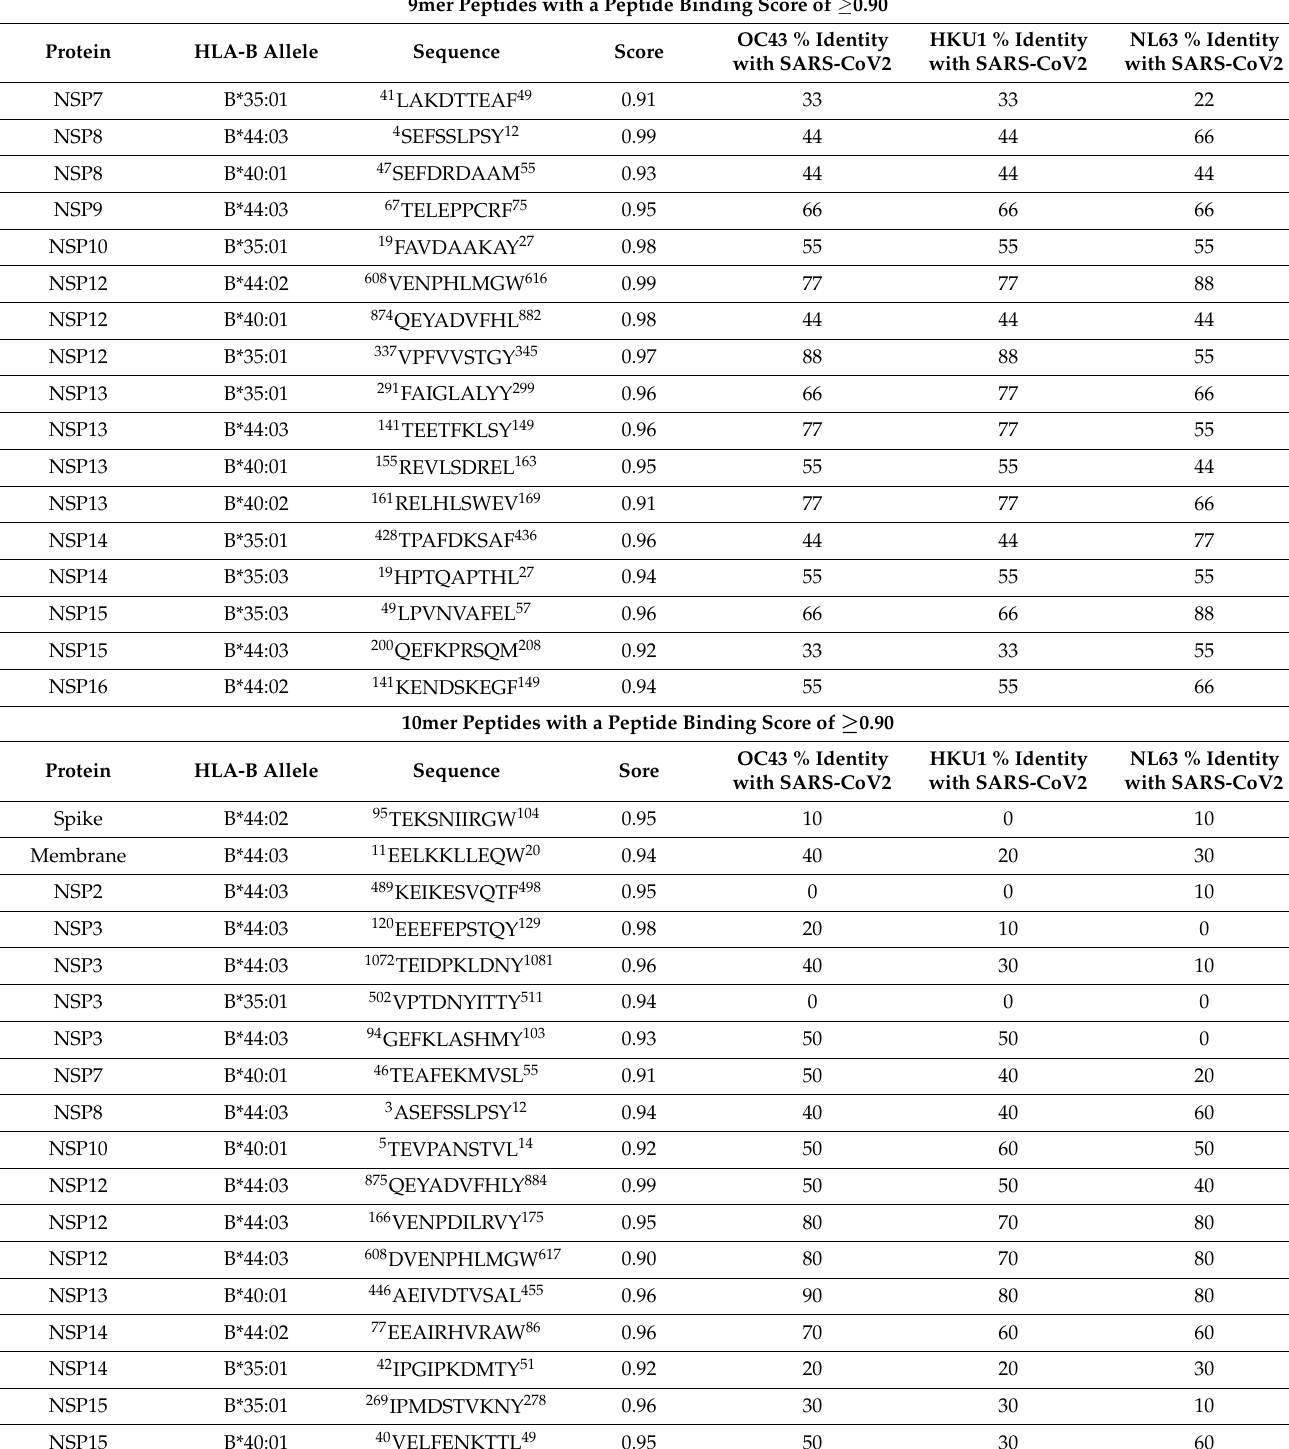
Table 2. Cont. 9mer Peptides with a Peptide Binding Score of ≥ 0.90